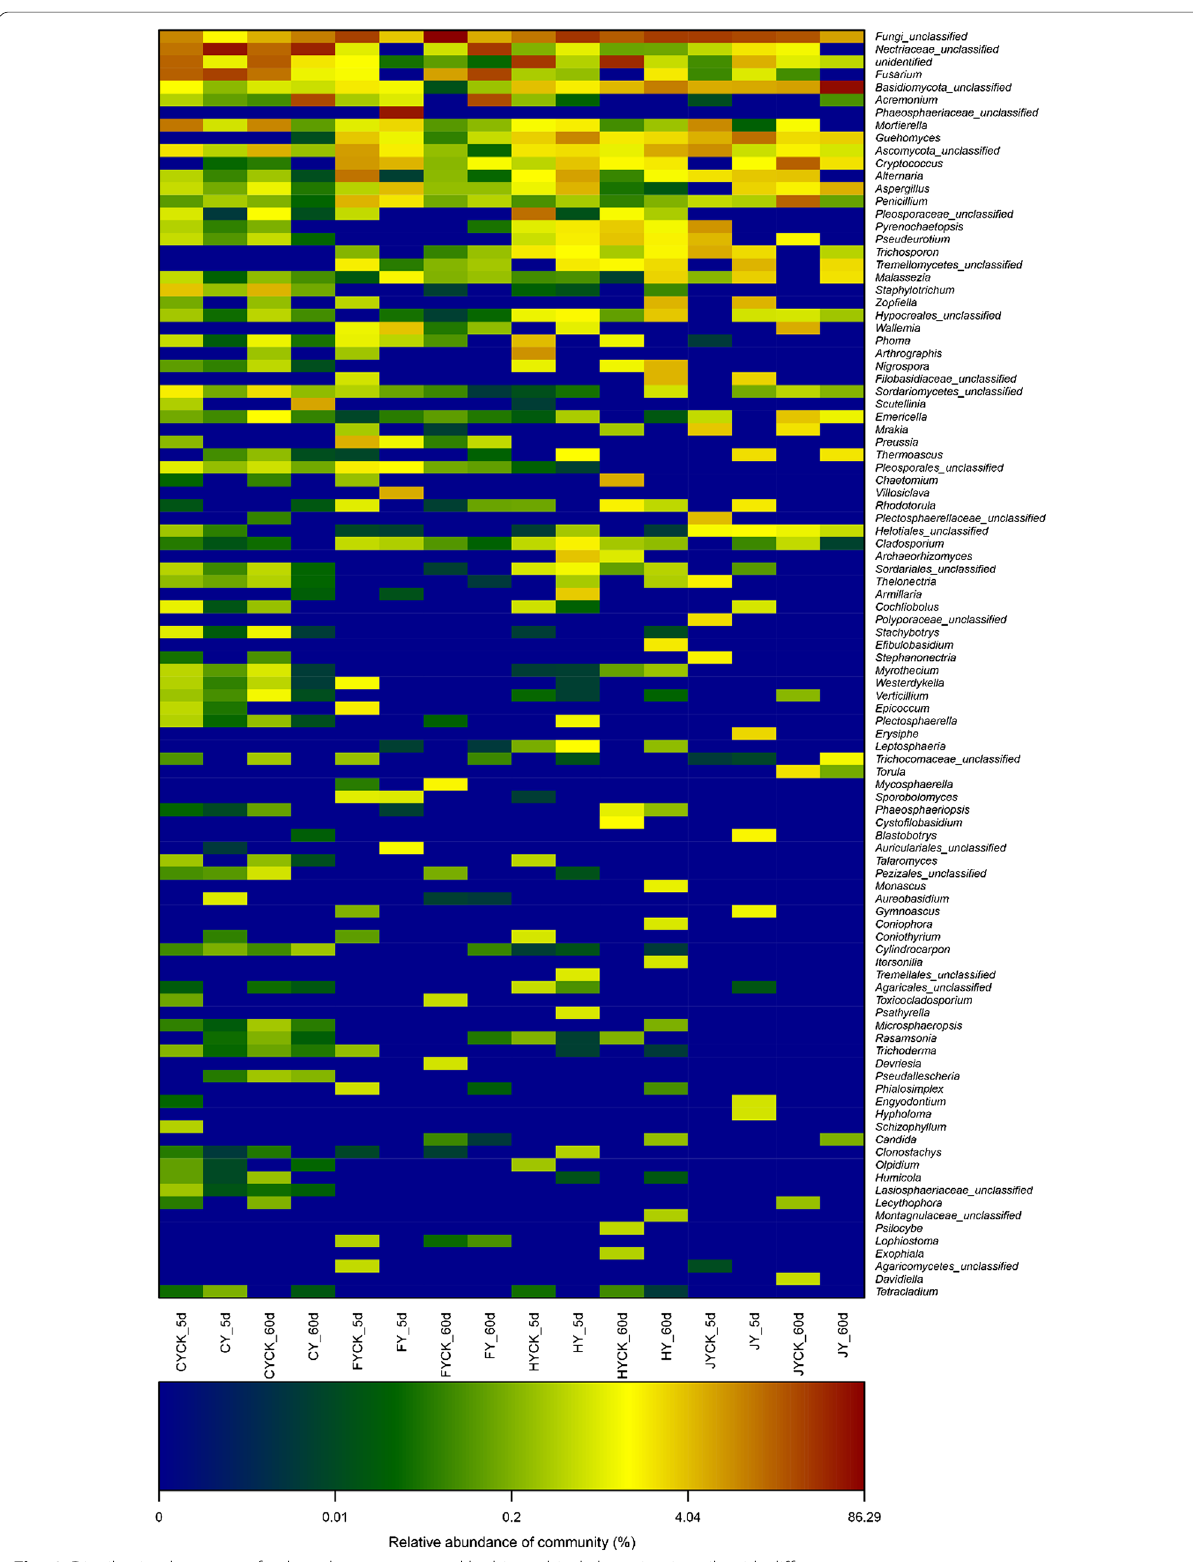
Fig. 6 Distribution heatmap of eukaryal genus arranged by hierarchical clustering in soils with different